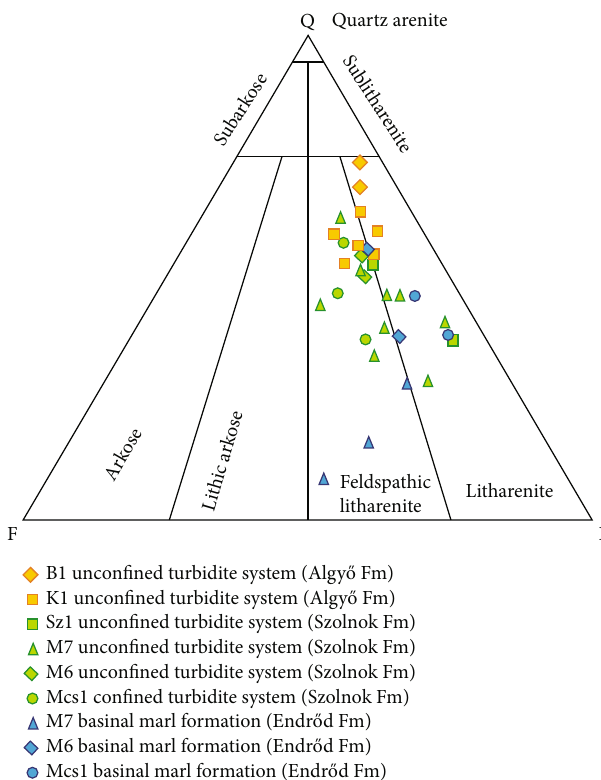
Figure 11: QFL classi fi cation of sandstones (after Folk